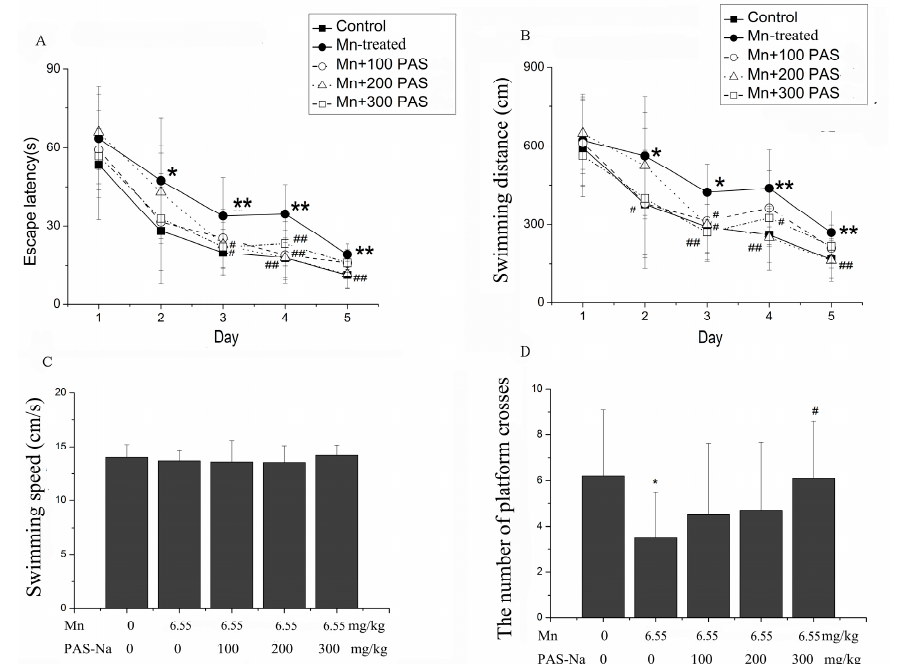
Figure 2. PAS-Na reverted the increase of escape latency and swimming distance induced by sub-chronical Mn exposure. ( A ) Escape latency; ( B ) Swimming distance; ( C ) Swimming speed; ( D ) The number of platform crosses. Data represent mean ± SD. N = 10 per group. * p < 0.05 or ** p < 0.01: significant as compared to control; # p < 0.05 or ## p < 0.01: significant as compared to the Mn-treated group.